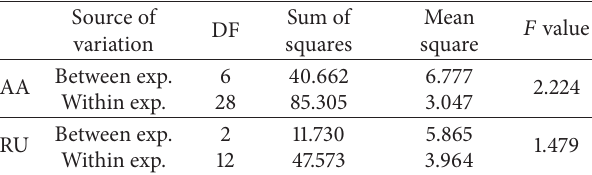
Table 4: One-way ANOVA testing for the different proposed methods used for the determination of AA and RU in Ruta C 60 tablets (batch number